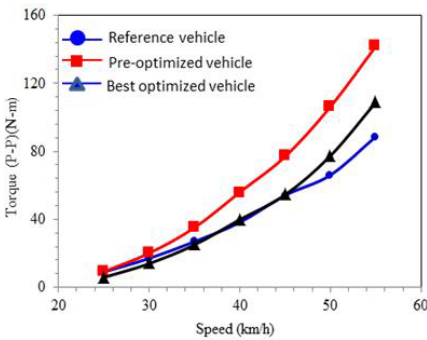
Figure 24. Steering torque simulation of